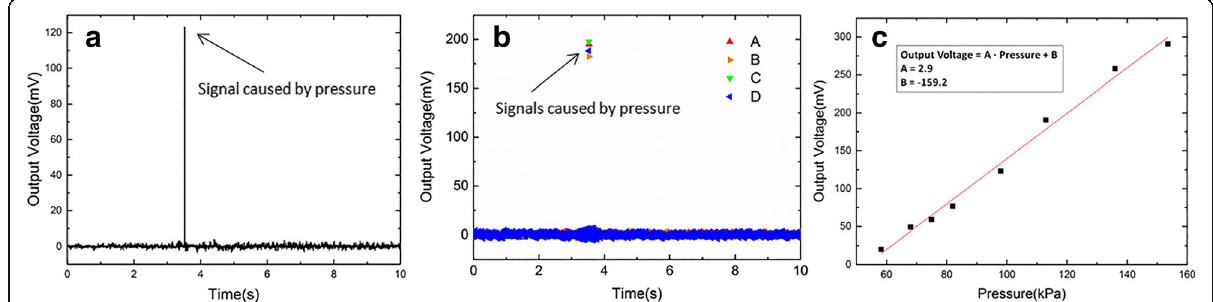
Fig. 3 Filtered output voltages for a an electrode square and b four electrode squares of the sensor array. c Liner calibration curve fit of the proposed